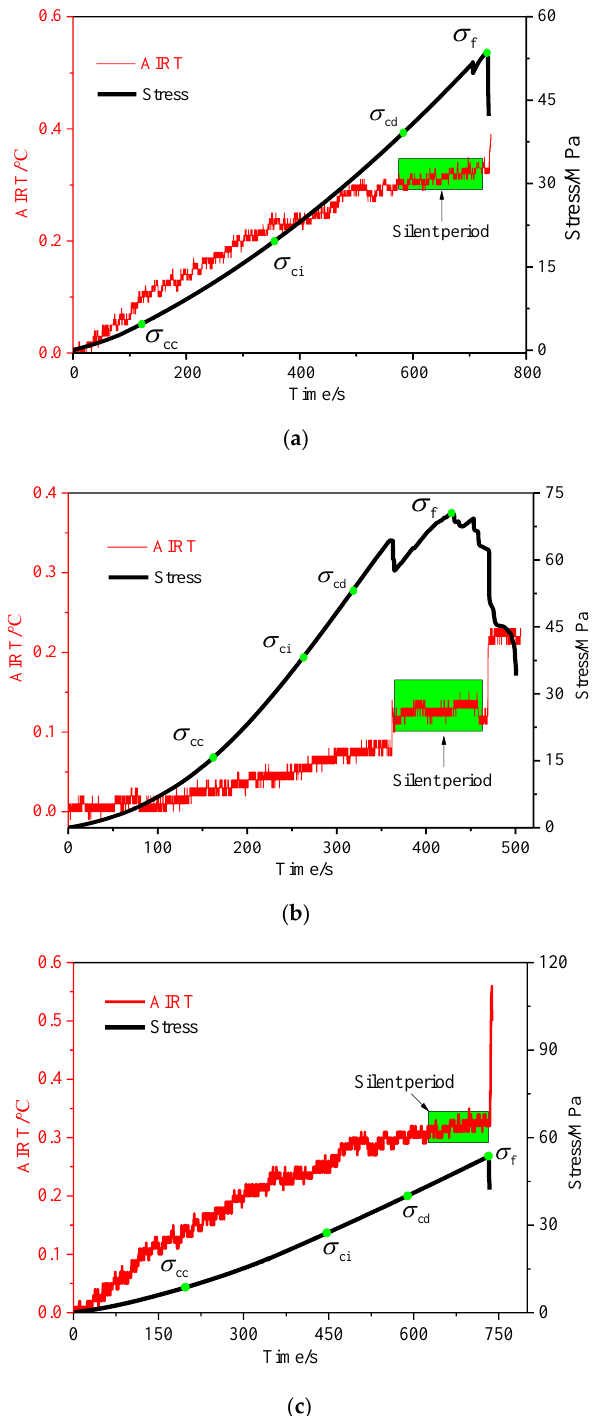
Figure 4. Increasing AIRT variations of rock samples. ( a ) Sandstone A 2. ( b ) Sandstone A 3. ( c ) Sandstone A 8.